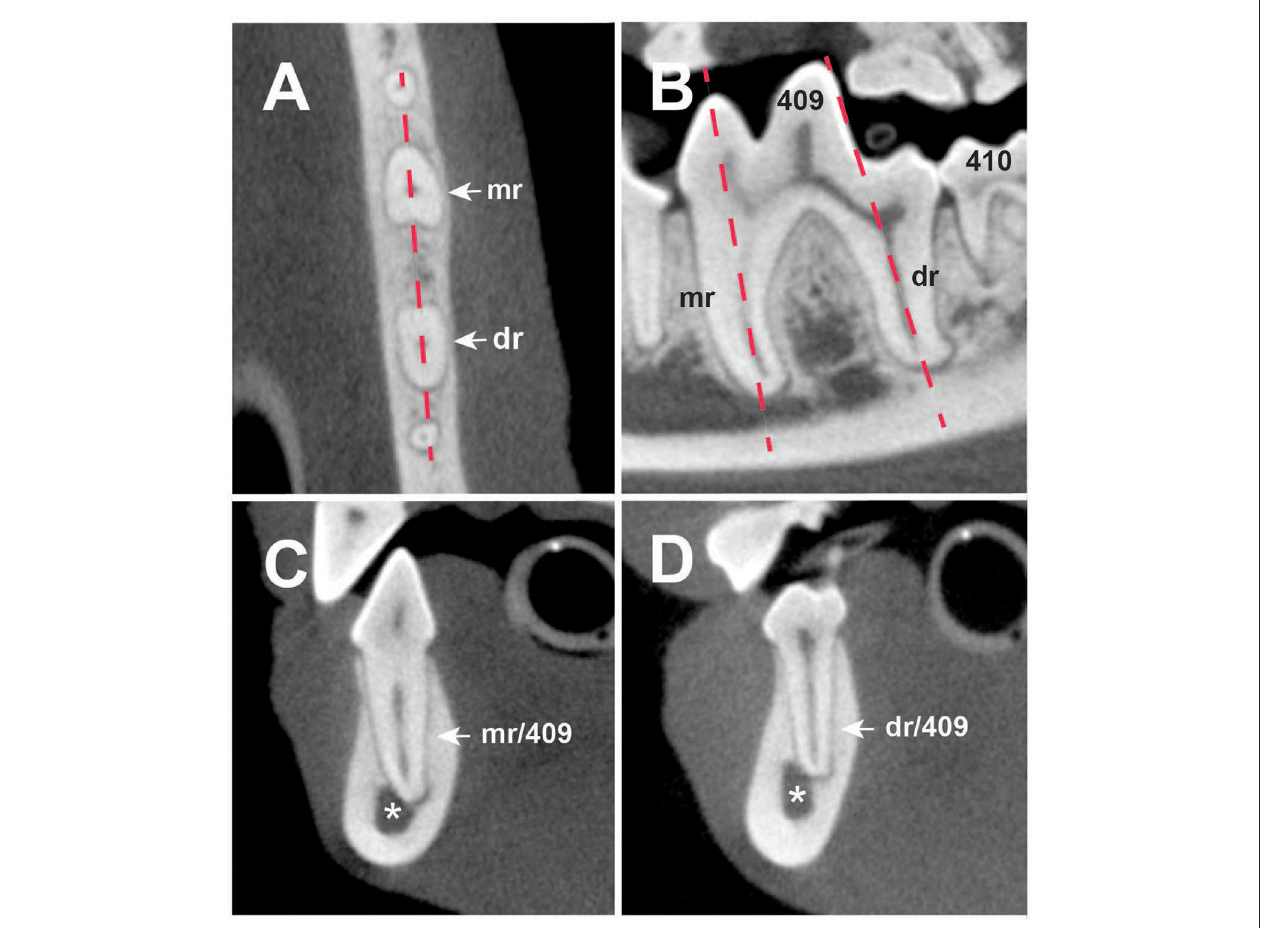
FIGURE 1 | (A) Dorsal, (B) sagittal, and (C,D) transversal multiplanar cone-beam computed tomography (CBCT) reconstructions of the right mandible of a 4-year-old English Cocker Spaniel. (A) Dashed line shows the sagittal reconstruction of 409 displayed on (B) . (B) Dotted lines present the axis of the mesial (mr) and distal (dr) roots of 409. (C) Mesial root transversal reconstruction (mr/409). Distal root transversal reconstruction (dr/409). (Asterisk) Mandibular canal; (409 and 410) right mandibular first and second molar